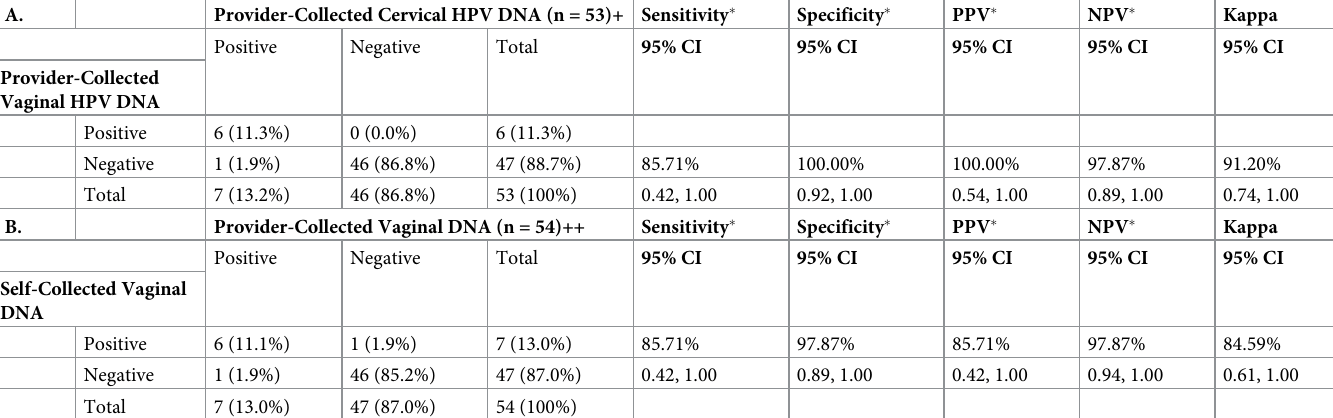
Table 5. Concordance of the provider-collected cervical HPV DNA specimen to the provider-collected vaginal HPV DNA specimen, and of the self-collected vaginal HPV DNA hybridization assay to the provider-collected vaginal HPV DNA specimen.